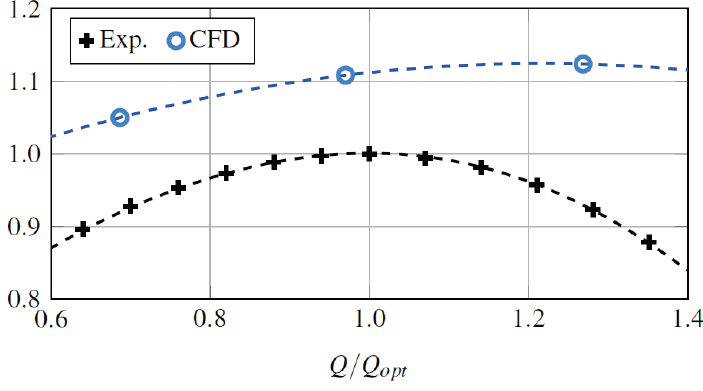
Figure 1. Discrepancy in inner efficiency η i between experiment and simulation (CFD) of a radial turbopump with n s = 13.4 1/min. The figure is taken from Juckelandt et al. [2].